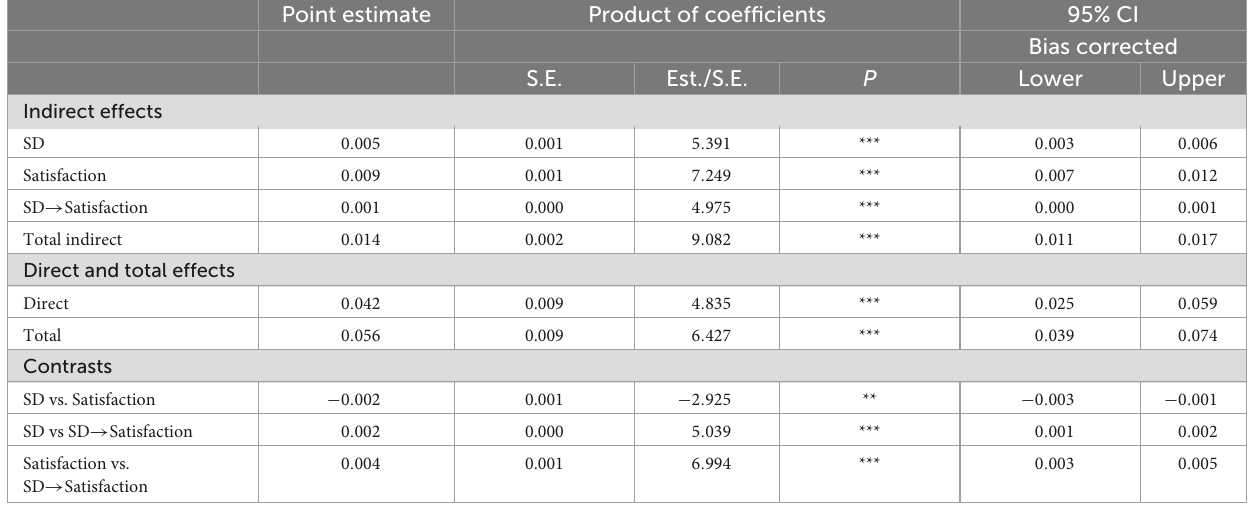
TABLE 10 Total, direct, and indirect effects of ACEs on chronic diseases, sleep duration and satisfaction as